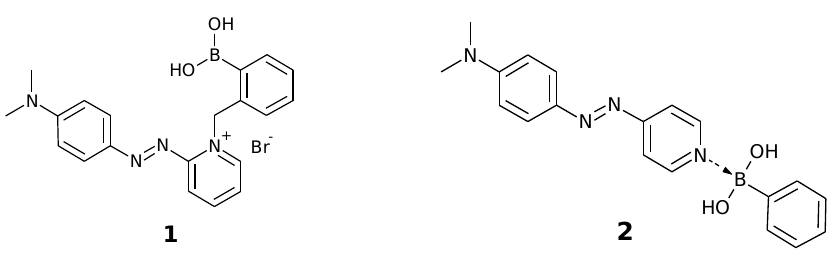
Figure 2. Chemical structures of dye 1 and 2 .